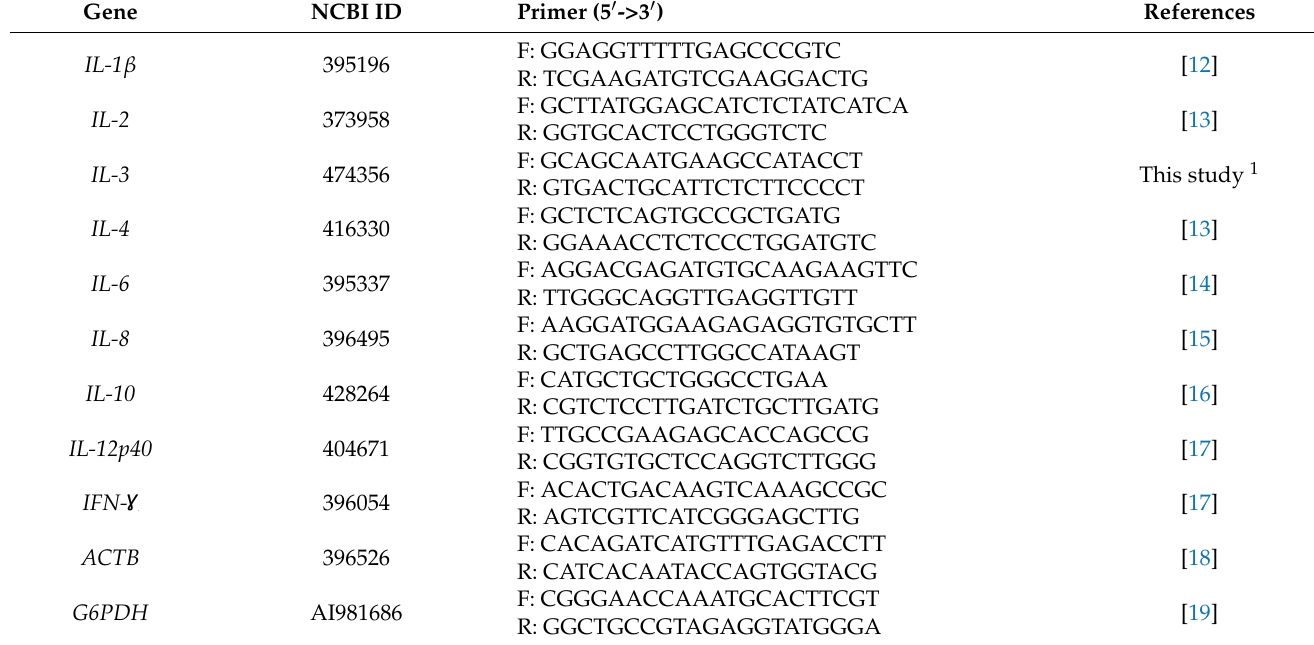
Table 2. Oligonucleotide primer sequences for